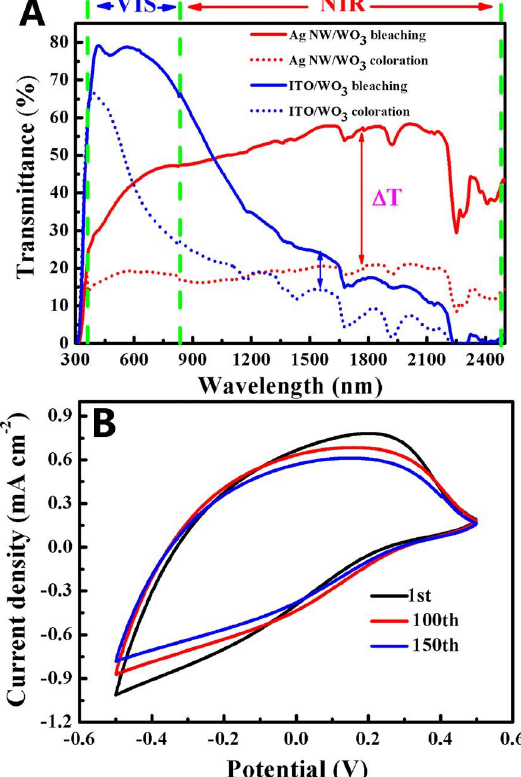
Figure 22. ( A ) Transmittance spectra of the ECDs using conventional ITO substrate and AgNW substrate in their colored and bleached states and ( B ) cyclic voltammograms for AgNW-based ECD with scan speed of 50 mV s −1 at the 1st, 100th, and 150th cycle [92].